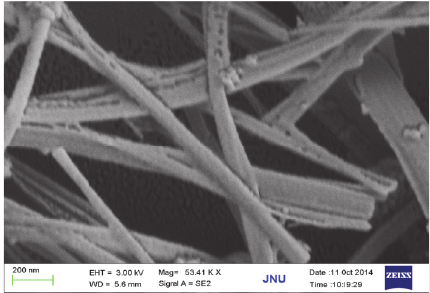
Figure 2: SEM spectrum of TiO 2 nanotubes treated by silanization.